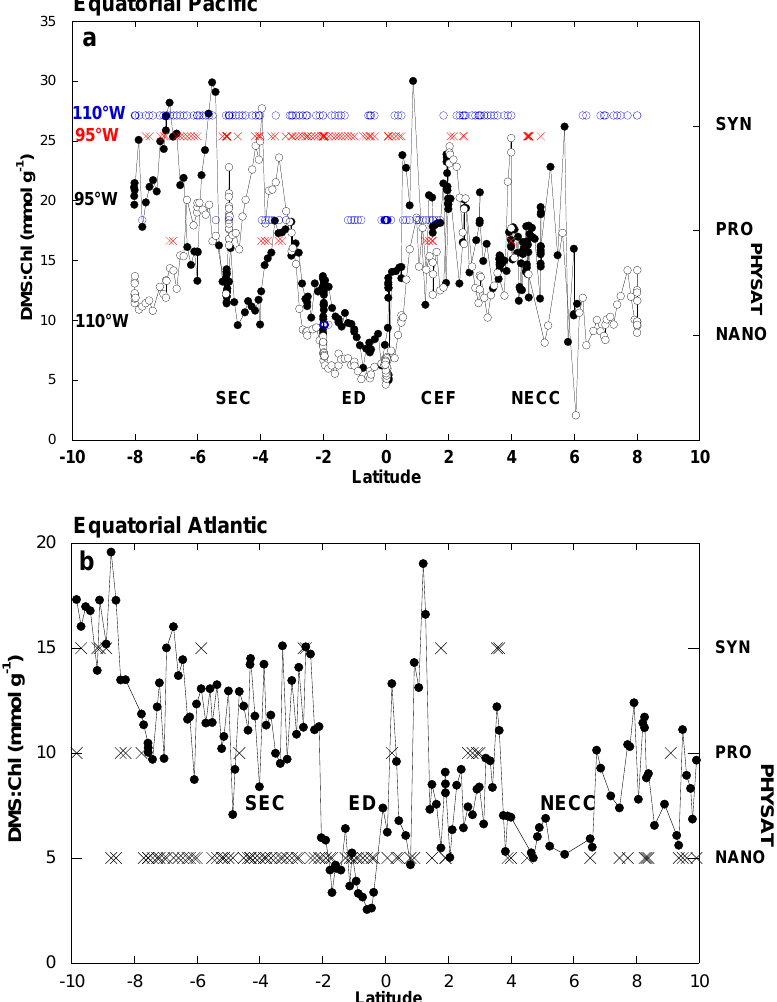
Fig. 10. (a) Latitudinal variations in DMS:Chl at 110 ◦ W and at 95 ◦ W (empty and full circles, respectively) and phytoplankton group dominance (blue circles and red crosses, respectively) in the Equatorial Pacific. (b) Same as (a) but in the Equatorial Atlantic between 15 ◦ and 35 ◦ W. NECC: north equatorial counter current, ED: equatorial divergence, CEF: convergent equatorial front, SEC: south equatorial